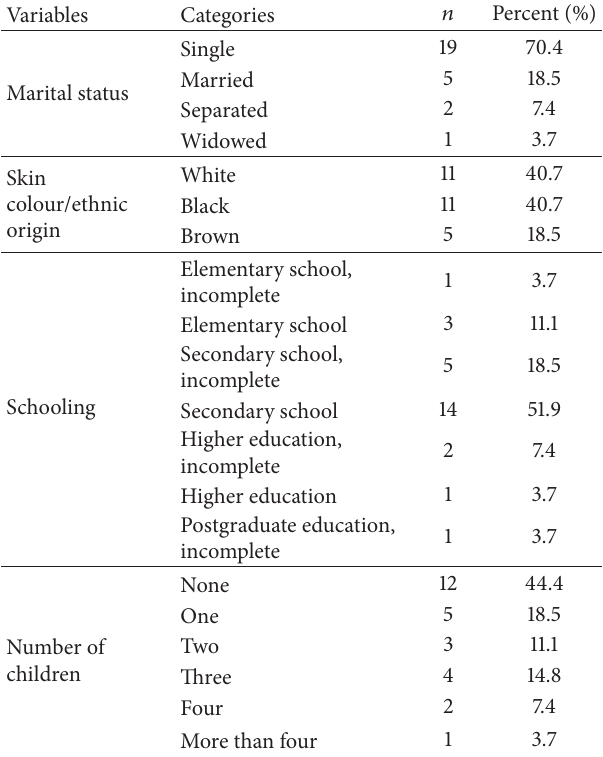
Table 3: Perception of women apprentice welders about physical, chemical, biological, and physiological risk factors ( 𝑛 = 27